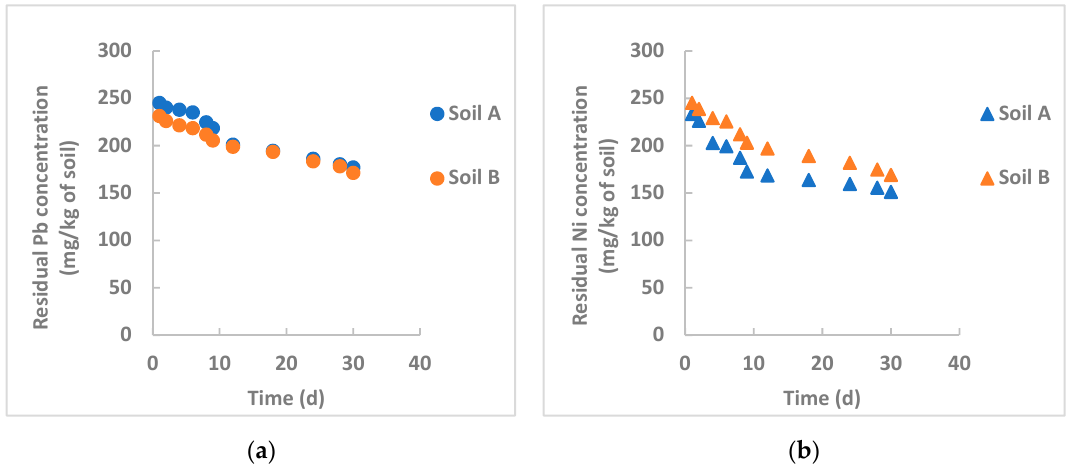
Figure 4. Remediation of nZVI particles synthesized using neem leaves (dosage: 0.1 g / kg of soil): ( a ) lead removal; ( b ) nickel removal.